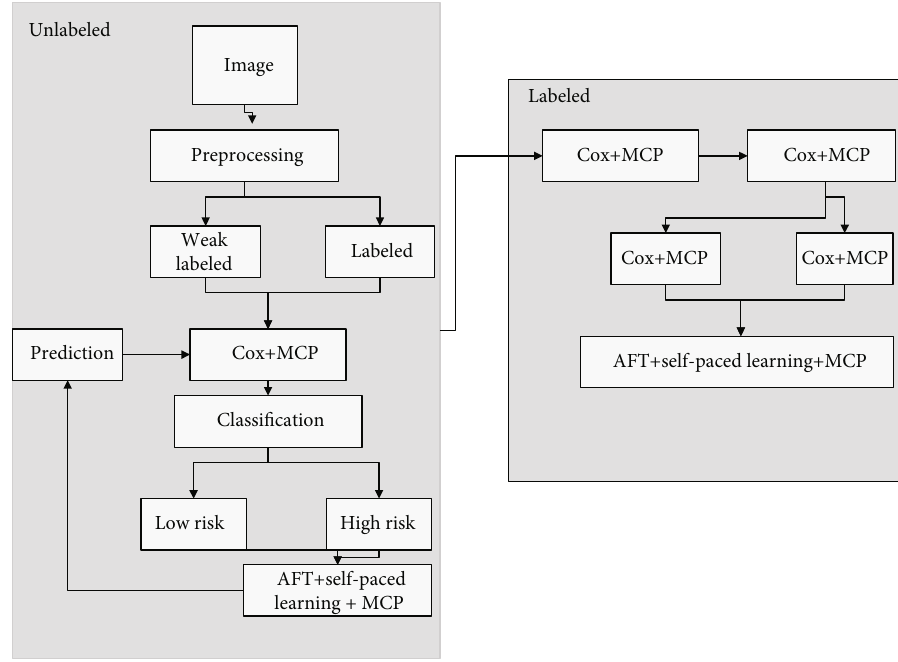
Figure 2: Overall framework of semisupervised associative